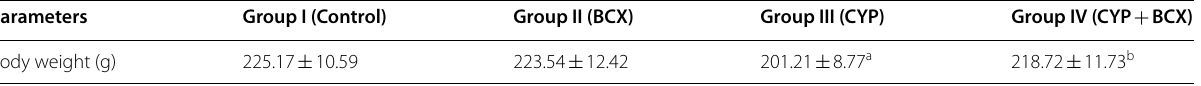
Table 2 Body weight of rats in the different studied groups Parameters